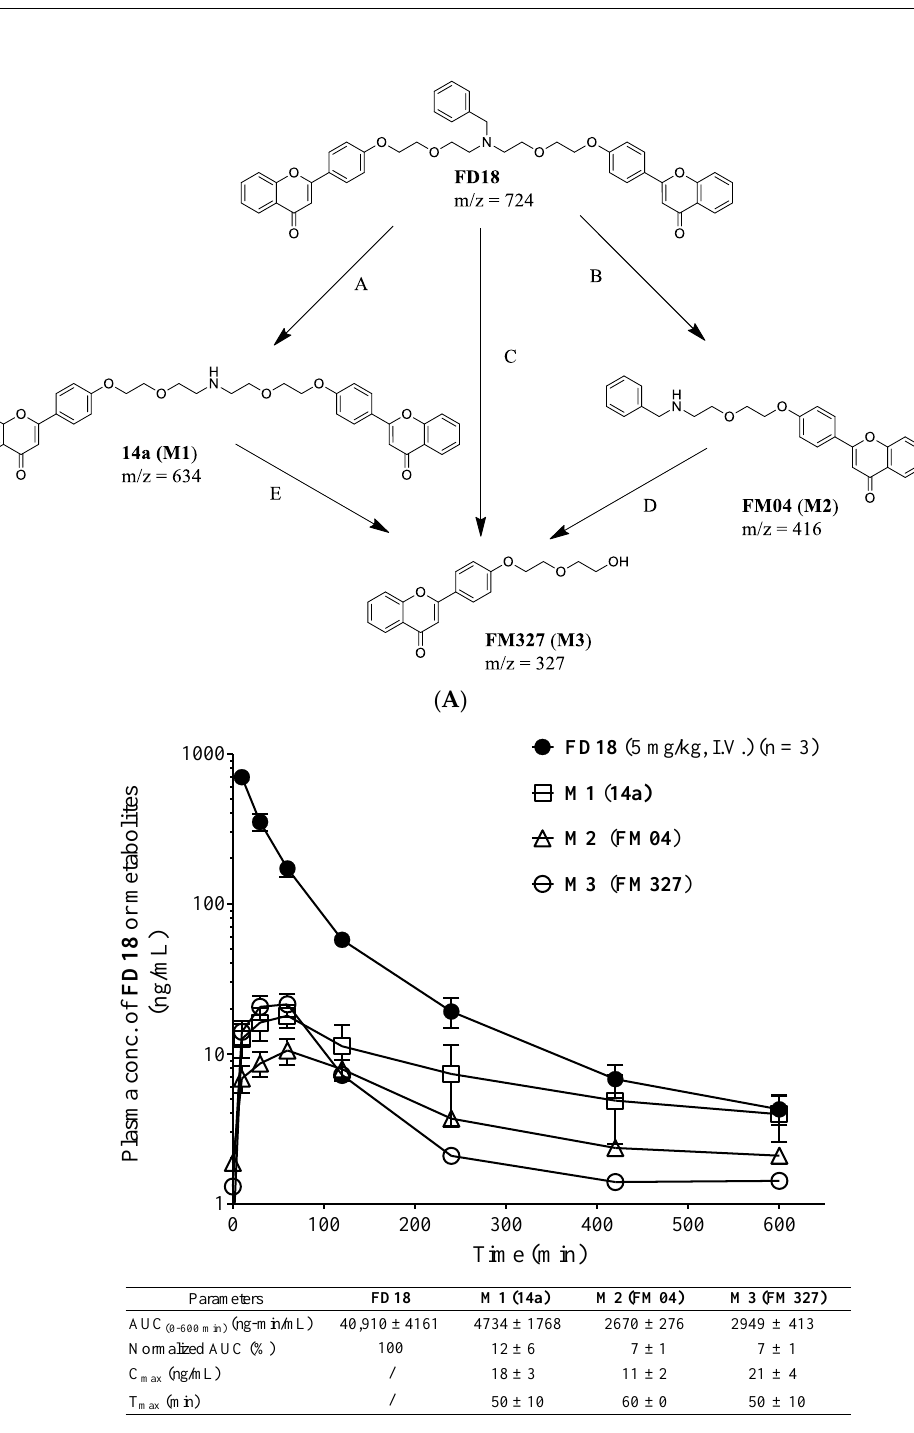
Figure 3. Proposed metabolism pathway of FD18 and its metabolites formed in vivo. ( A ) metabolism study of FD18 was conducted on human liver microsomes (HLM) and rat liver microsomes (RLM) in vitro. Chemical structure of the 3 metabolites was predicted by LC/QTOF-MS/MS and confirmed by the synthetic compounds (Figure 2E – J). The pathways for biotransformation of FD18 into FM04 was proposed. ( B ) plasma concentration profile of FD18 and the in vivo formation of metabolites M1 , M2 and M3. After I.V. injection of FD18 (5 mg/kg) into mice, plasma was collected at 10, 30, 60, 120, 240, 420 and 600 min, respectively. The concentration of FD18 at each time point was determined by UPLC-MS/MS. Its plasma concentration was further quantified with peak area ratio of FD18